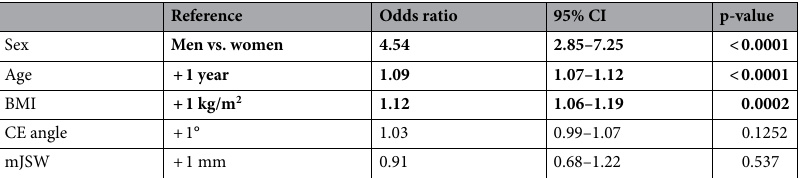
Table 3. Association of PGD with hip parameters (multivariate analysis). Odds ratios are calculated by multiple logistic regression analysis on 2962 hips. PGD pistol grip deformity, 95% CI 95% confidence interval, BMI body mass index, CE angle center–edge angle, mJSW mean joint space width. Bold values indicate a statistically significant association with PGD.